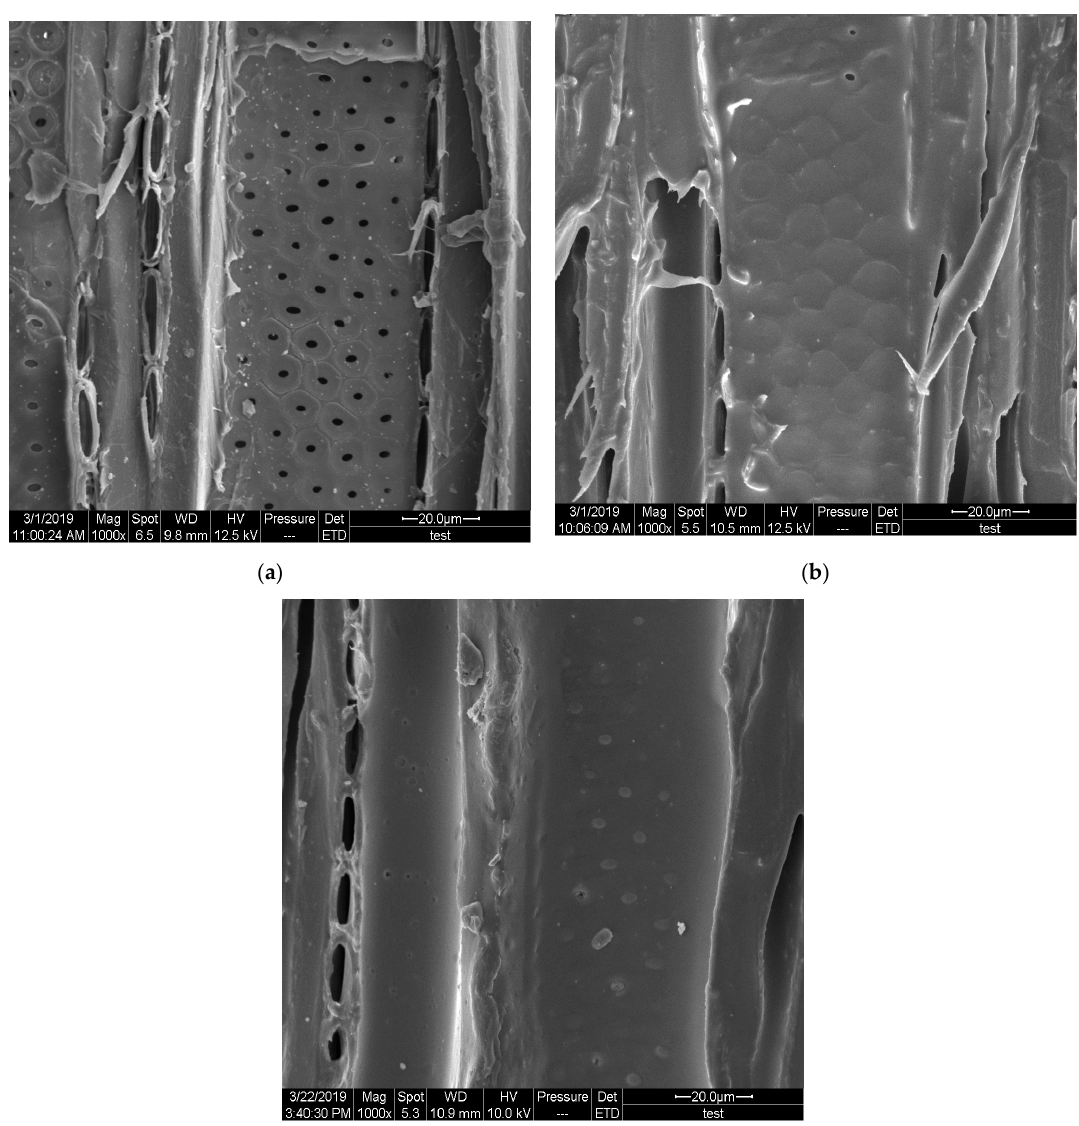
Figure 2. SEM spectra of ( a ) the untreated wood, ( b ) the sol coating composite, ( c ) and the sol coating composite under UV light radiation (340 nm) for 480 h.